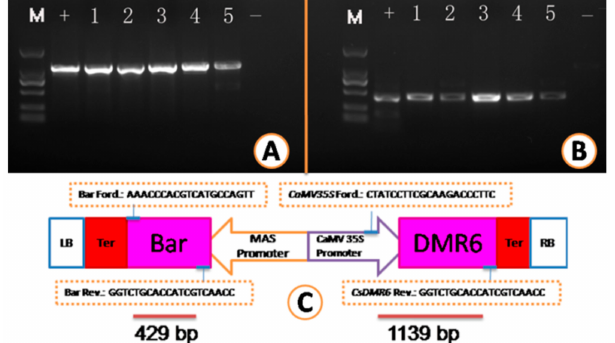
Figure 5. Gel electrophoresis of PCR amplified DNA from transgenic plants. 2000 kb DNA ladder (M), transgenic plants samples (1–5), positive control (+), negative control ( − ). ( A ) PCR amplicon (1139 bp) from CaMV35S forward and CsDMR6 reverse primers.( B ) PCR amplicon (429 bp) from Bar (bacterial bialaphos resistance gene) forward and reverse primers. ( C ) T-DNA constructs showing corresponding primer sites.